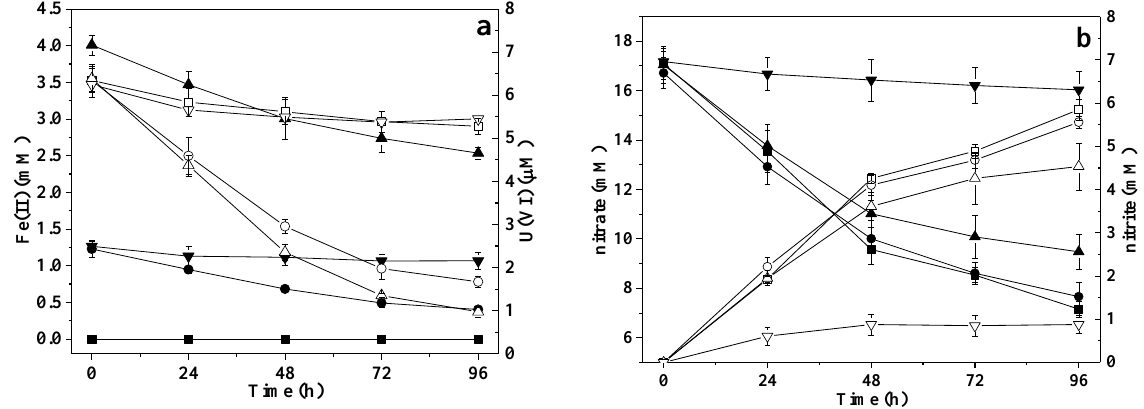
Figure 4. The effects of Fe(II) on changes in Fe(II), U(VI), nitrate, and nitrite concentrations during the growth of Clostridium sp. PXL2. ■ and □, 0 mM Fe(II) (control); ● and ○ , 1.2 mM Fe(II); ▲ and △ , 4.0 mM Fe(II); ▼ and ▽ , 1.2 mM Fe(II) (uninoculated). Filled symbols, Fe(II) and nitrate; open symbols, U(VI) and nitrite. ( a ), Fe(II) and U(VI); ( b ), nitrate and nitrite. Data shown are means ± SD ( n = 3).